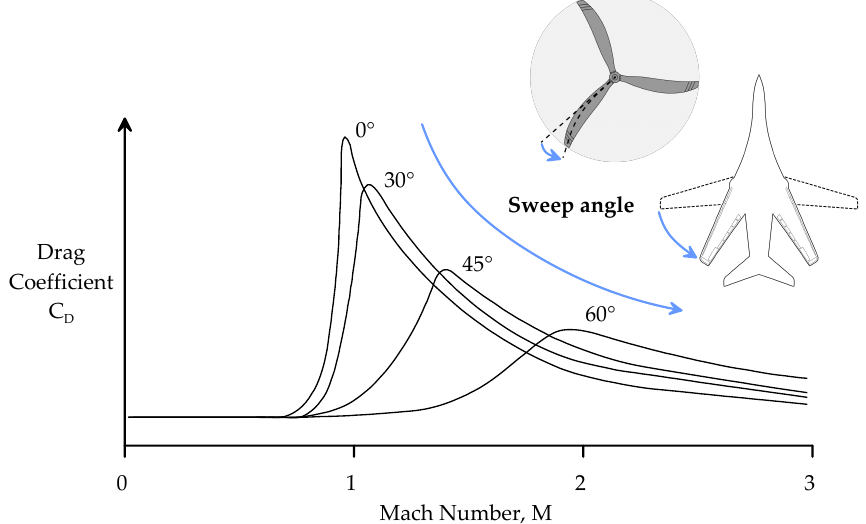
Figure 2. Drag rise due to cruise Mach and the effect of wing sweep. Adapted from